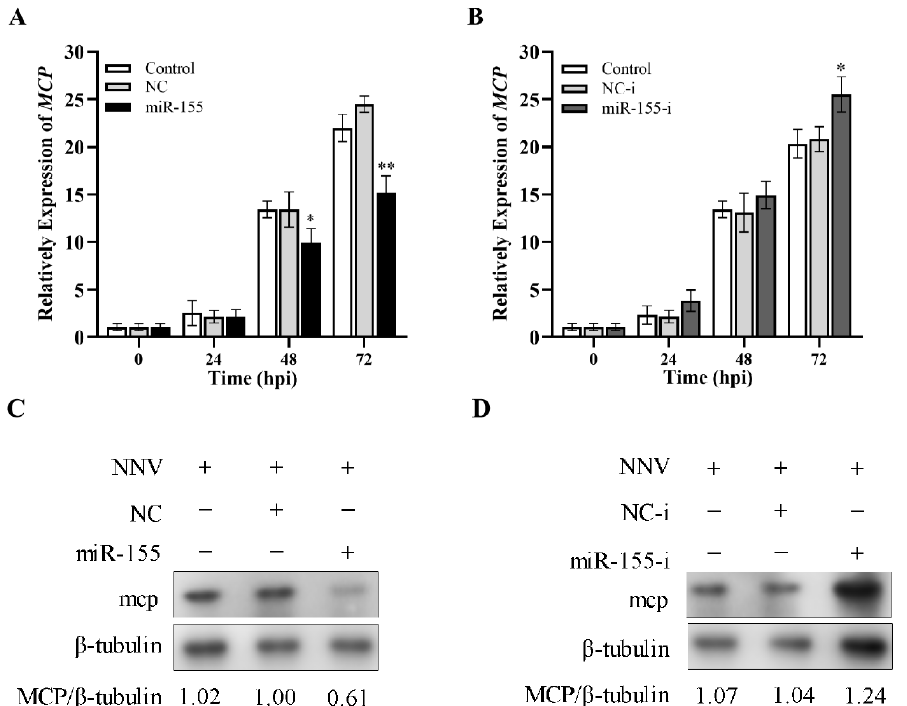
Figure 8. Cal-miR-155 inhibits NNV replication in CAB cells. After CAB cells were transfected with the cal-miR-155 mimic ( A ) and inhibitor ( B ) for 24 h, they were infected with NNV (MOI = 10). Then, the cells were harvested and the expression of the NNV MCP gene was detected at different time points (24, 48, and 72 hpi) by qRT-PCR. β -actin was selected as the reference gene. Data in this assay are expressed as mean ± SD ( n = 3). (** stands for p < 0.01; * stands for p < 0.05.) CAB cells transfected with the cal-miR-155 mimic (miR-155) ( C ) or the cal-miR-155 inhibitor (miR-155-i) ( D ) for 24 h were infected with NNV at a MOI of 10. Then, the NNV mcp protein level was detected by western blot, and β -tubulin was used as the internal control. The gray values of NNV MCP/ β -tubulin are shown on the last line.